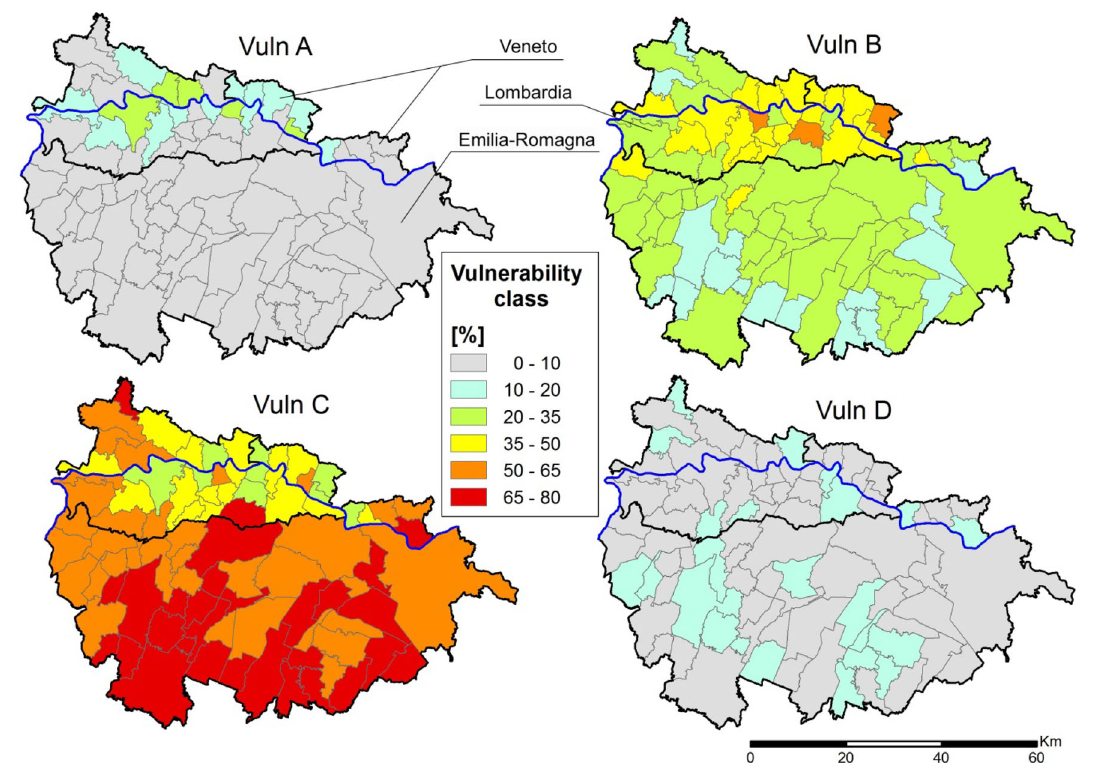
Fig. 3 Vulnerability distribution of residential buildings into the classes A–D (buildings in classes E and F are not present). The built area (in m 2 ) refers to the data updated to the 2011 ISTAT census. The